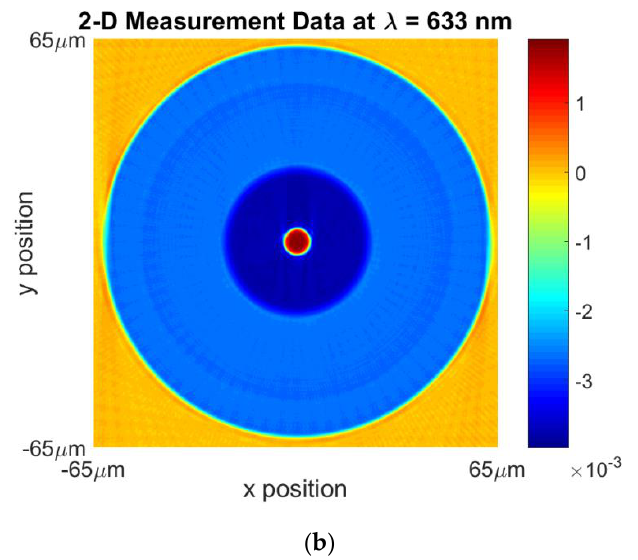
Figure 1. ( a ) 3-D schematics of a biconic FT based on a DCF. L represents the biconic taper elongation length, ρ and n are the radii and the refractive indexes of each DCF layer (rod, gap, tube), respectively. The refractive index in each layer is highlighted at the taper end’s face. ( b ) 2-D experimental data of the refractive index distribution from the DCF used in this work.